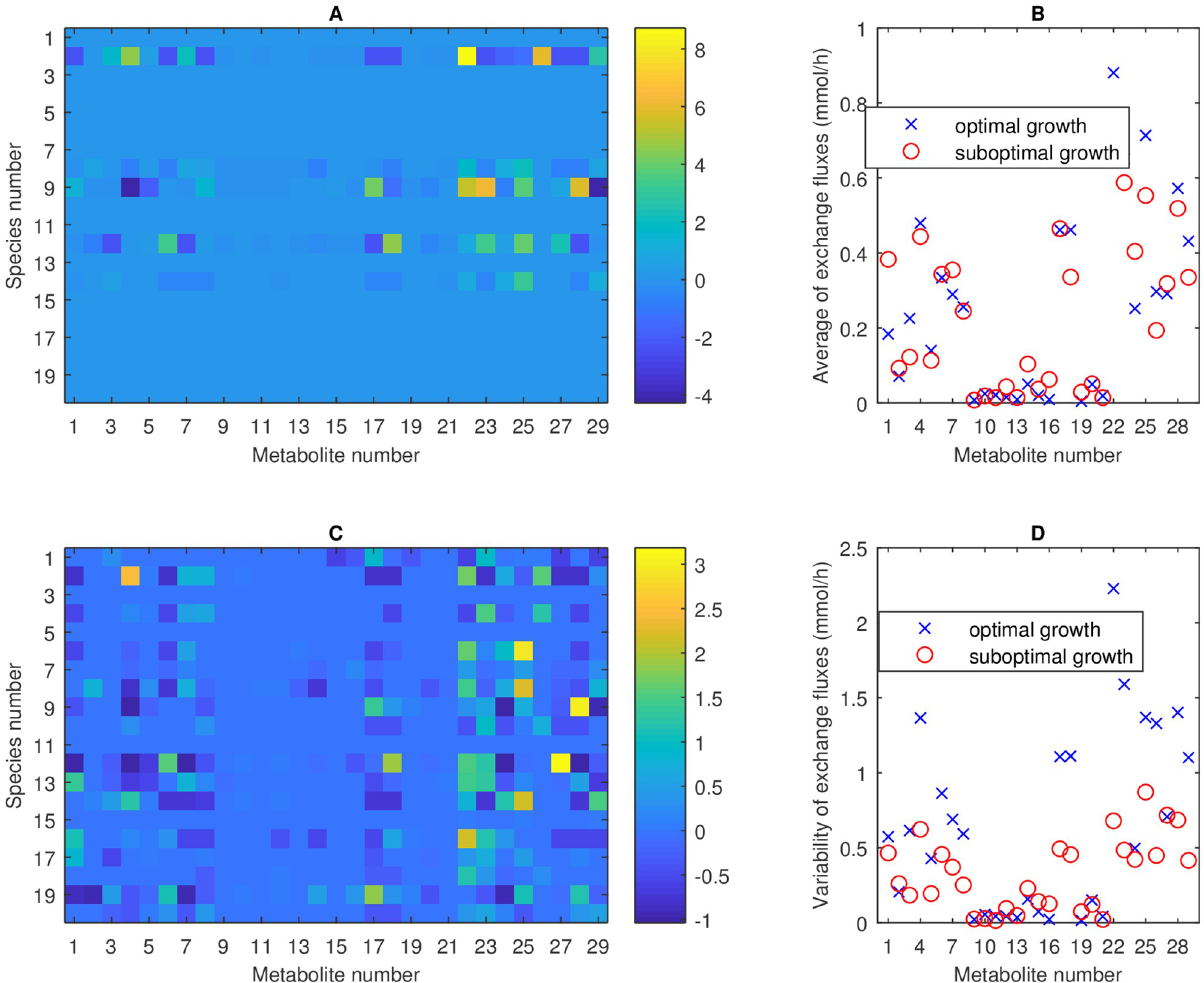
Fig 6. Metabolite crossfeeding for the 20-species community and the Western diet for the maximal growth case and 34 suboptimal growth cases binned around 79% of the maximal growth rate. (A) Maximal growth heatmap of uptake (negative) and secretion (positive) rates in mmol/h for each crossfed metabolite (numbered in S1 Table) and each species (numbered in Table 1). (B) Suboptimal growth heatmap of uptake and secretion rates in mmol/h for each crossfed metabolite and each species averaged across 34 cases. (C) Absolute value of the exchange rate of each crossfed metabolite averaged across the 20 species and the 34 cases (for suboptimal growth). (D) Standard deviation of the exchange rates associated with Fig